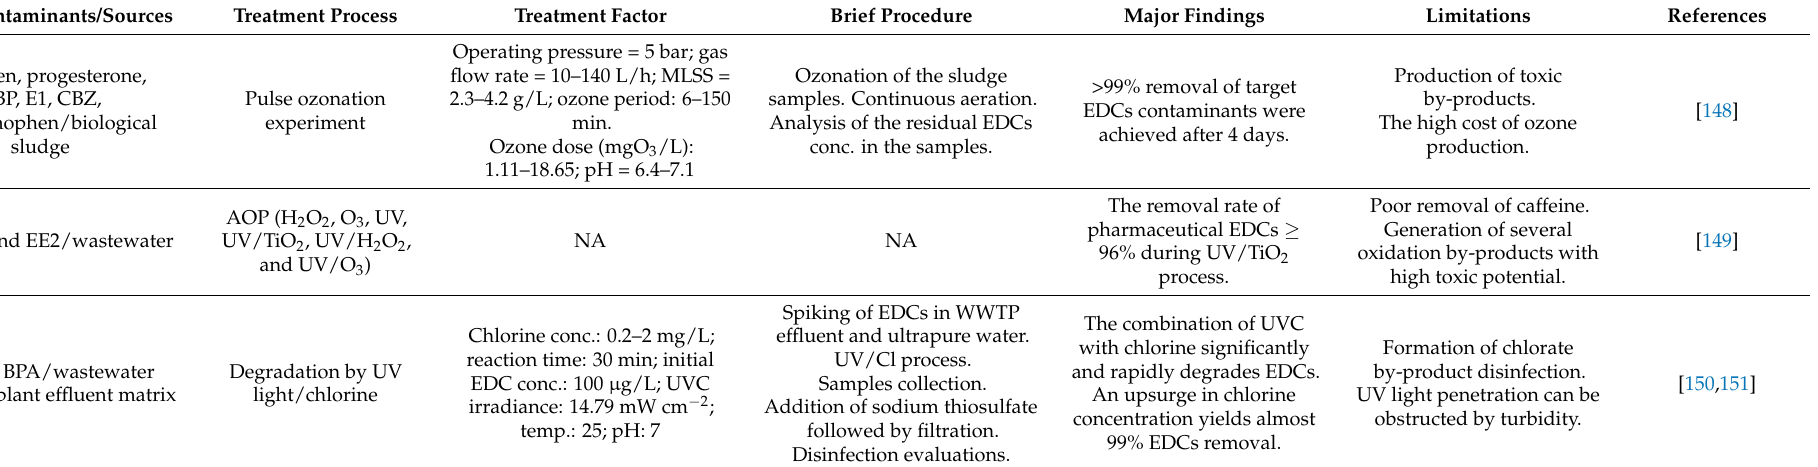
Table 5. Removals of EDCs during ozonation and advanced oxidation